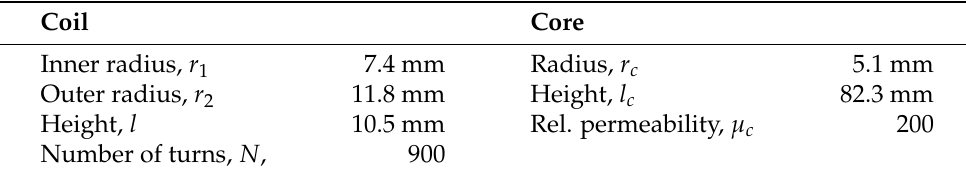
Figure 2. Shematic diagram of the measurement system. Table 1. Parameters of the